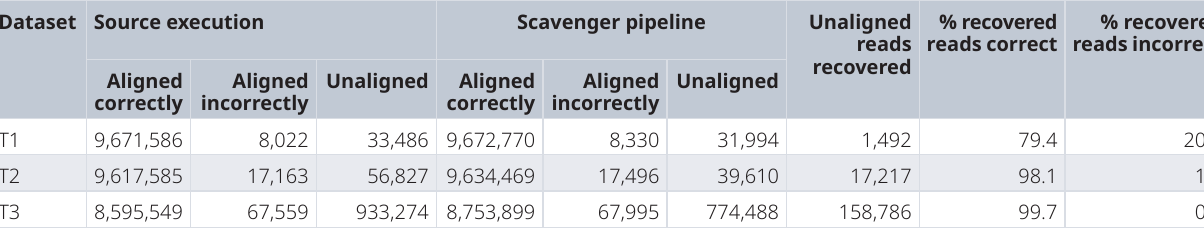
Table 2. Alignment statistics for simulated datasets before and after Scavenger recovery using default parameters for STAR. Dataset Source